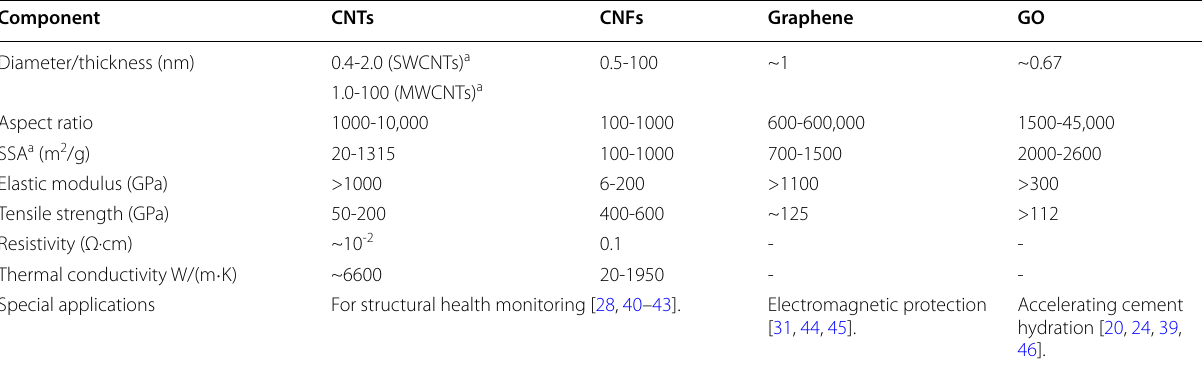
a SWCNTs and MWCNTS are single-wall CNTs and multi-walled CNTs, respectively. SSA is a specific surface area